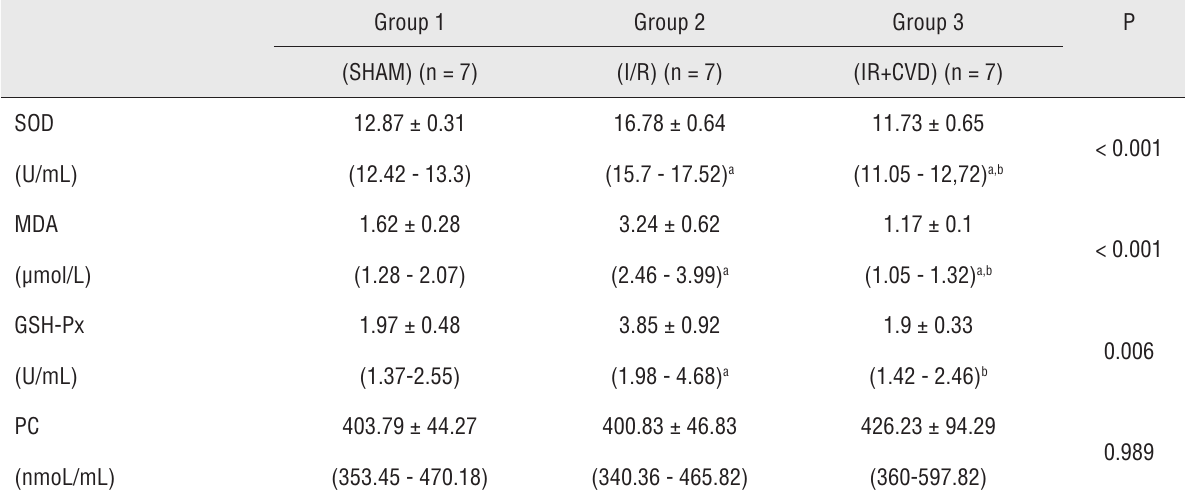
Table 2 - The serum antioxidant activities and levels of MDA and PC in all groups and statistical